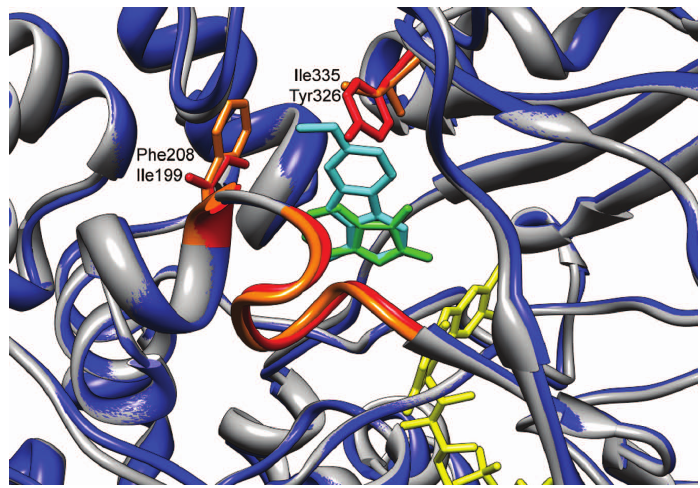
Figure 3 An overlay of the substrate-binding sites of human MAO B (PDB file 1OJA) and human MAO A (PDB file 2Z5X). The figure highlights residue differences in the active sites of these two enzymes that affect substrate specificity, and identifies the substrate- cavity forming loop that appears to be conserved in the two enzymes. MAO B is colored blue, and Ile199, residues 201–206, and Tyr326, are colored red; the inhibitor isatin is green. MAO A is pictured in dark gray, with Phe208, residues 210–216, and Ile335 colored orange; the inhibitor harmine is cyan. The flavin cofactor is shown in